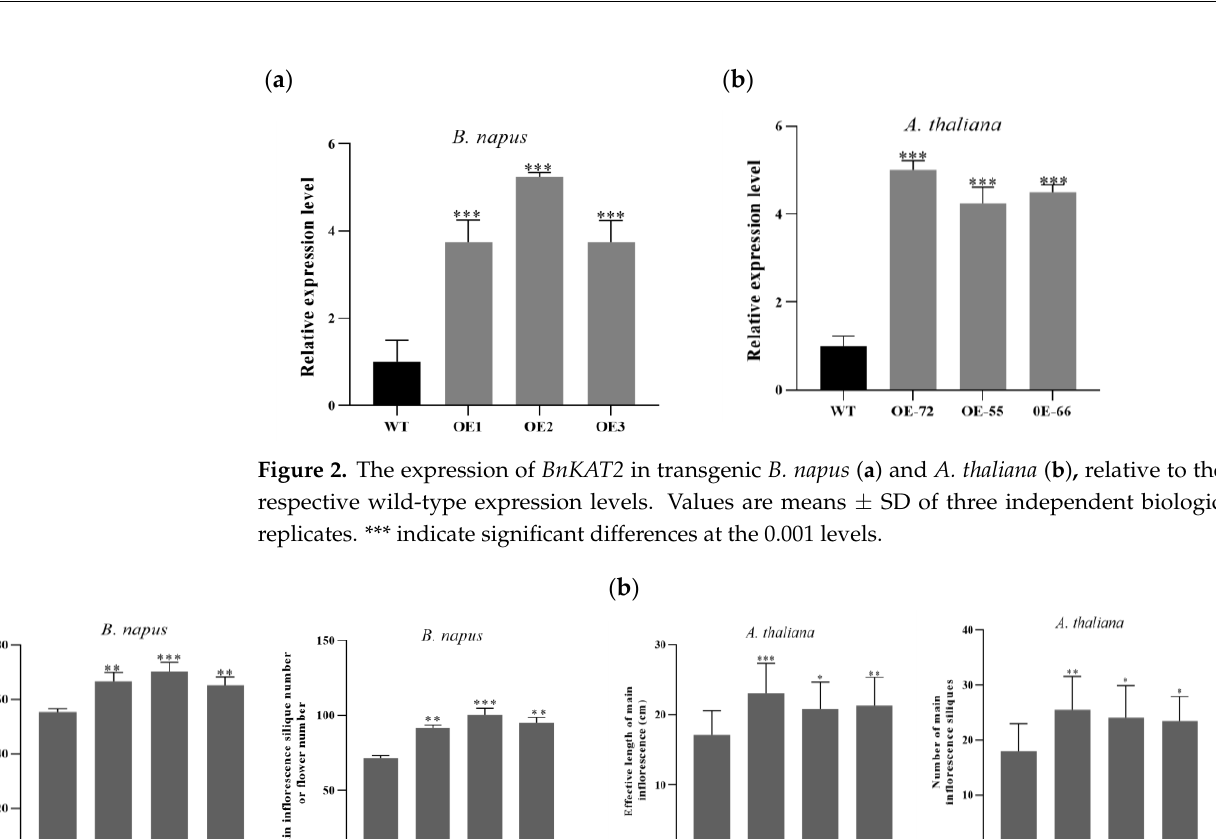
Figure 3. Comparison of the effective main inflorescence length and number of siliques produced by the transgenic and wild-type B. napus ( a ) and A. thaliana ( b ) plants. Data are means ± SD ( n = 3 biological replicates of 20 plants per genotype). *, **, and *** indicate significant differences at the 0.05, 0.01, and 0.001 levels, respectively.